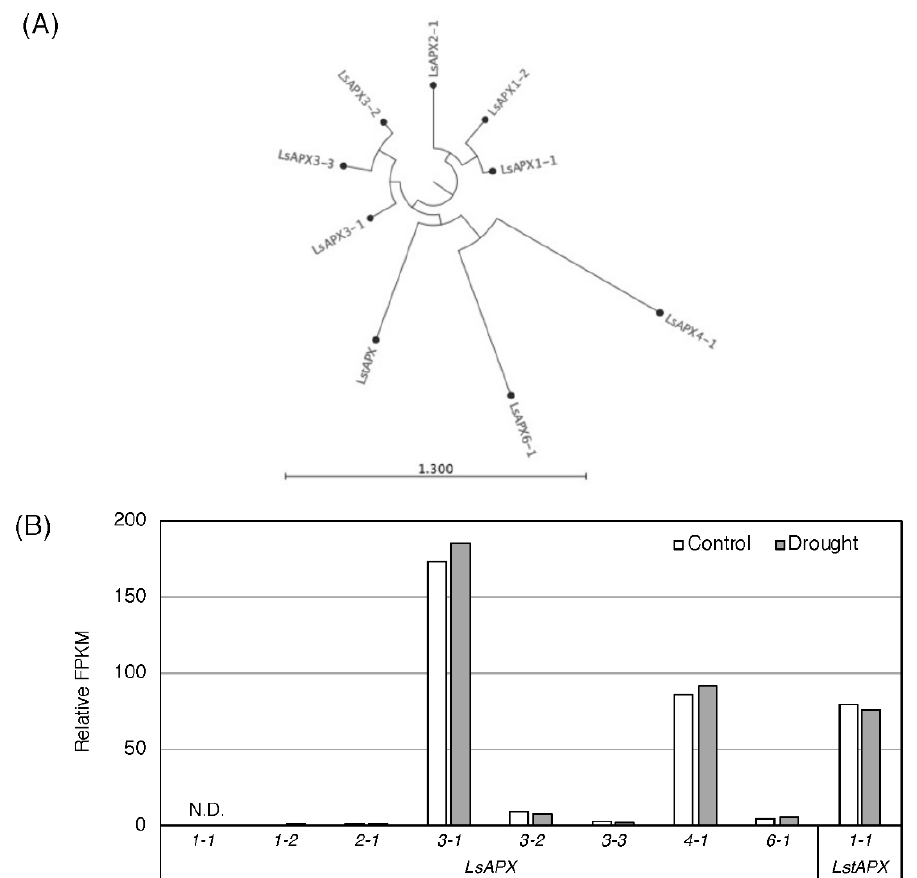
Figure 3. Phylogenetic tree of APX and relative expression of APX genes during dehydration in lettuce. The protein sequences of 9 APX were obtained from a lettuce genome database ( Lactuca sativa v8.0 genome), and the phylogenetic tree was constructed ( A ). The relative expression of APX was compared via RNA-seq ( B ). The expression levels of APX were evaluated with fragments per kilobase per million reads (FPKM) between the control (white) and drought stress (gray). Each relative FPKM was calculated on the basis of the control treatment of LsAPX2-1 .